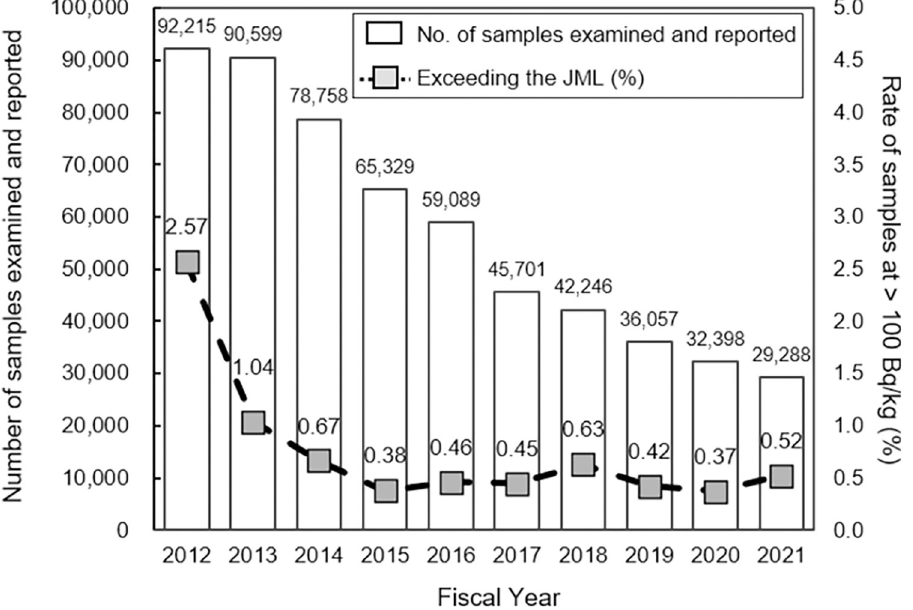
Fig 1. The “general foodstuffs” examined and reported exceeding the JML of 100 Bq/kg from FY 2012 to 2021. The number of reported samples excluding meat from all livestock is indicated above the bar. The proportion of samples exceeding 100 Bq/kg within each year were